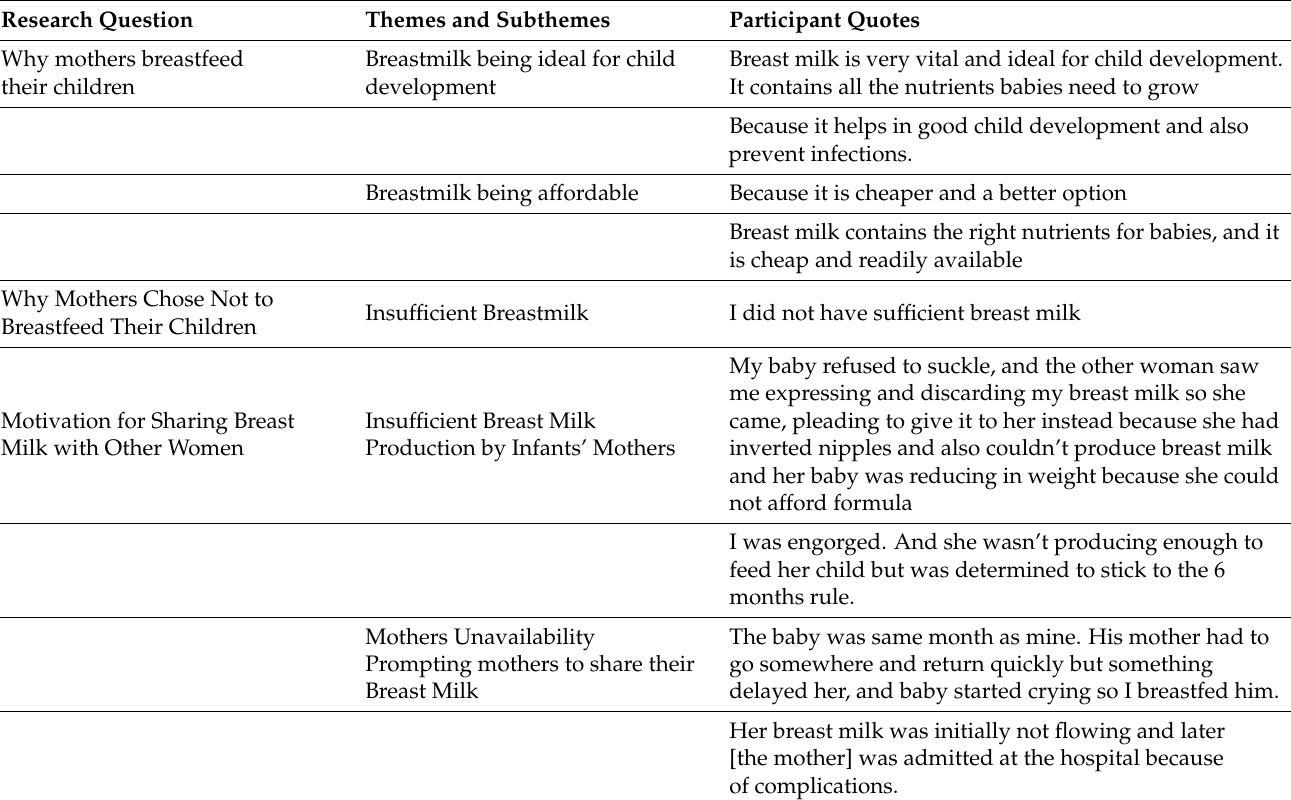
Table A1. Summary of study questions, themes, subthemes and participant